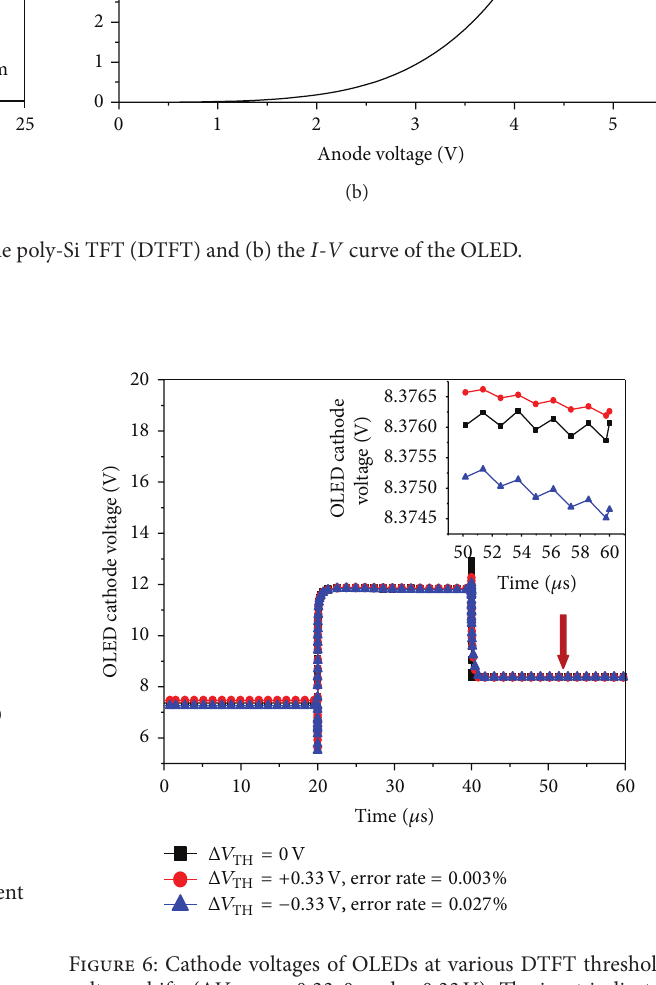
Figure 6: Cathode voltages of OLEDs at various DTFT threshold = −0.33, 0, and + 0.33 𝑉) . The inset indicates voltage shifts (Δ𝑉 TH that the variation is less than 0.005 V during the emission